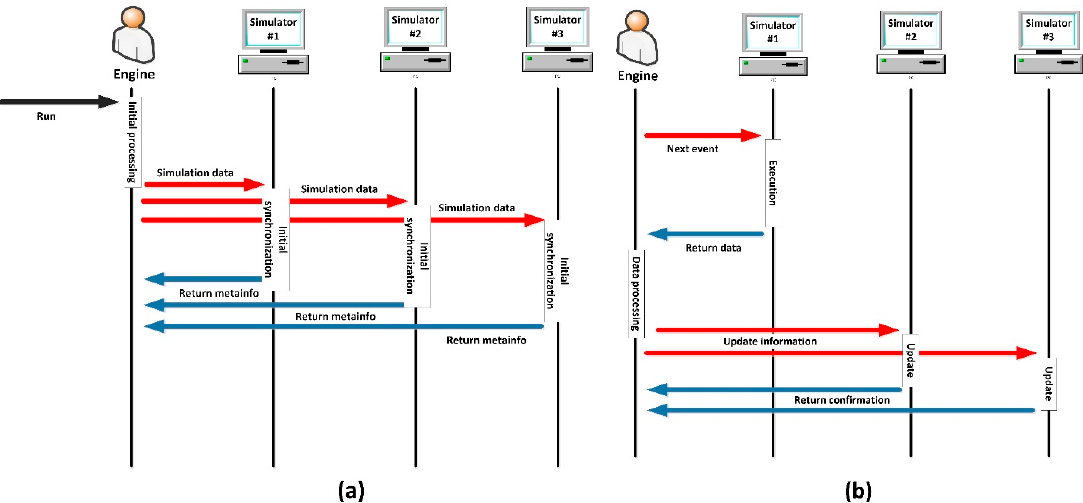
Figure 8. ( a ) Sequence diagram describing the initial synchronization process in a co-simulator; ( b ) Example of a sequence diagram about the stop-and-wait coordination mechanism when using a federated co-simulation controlled by a third-party engine.